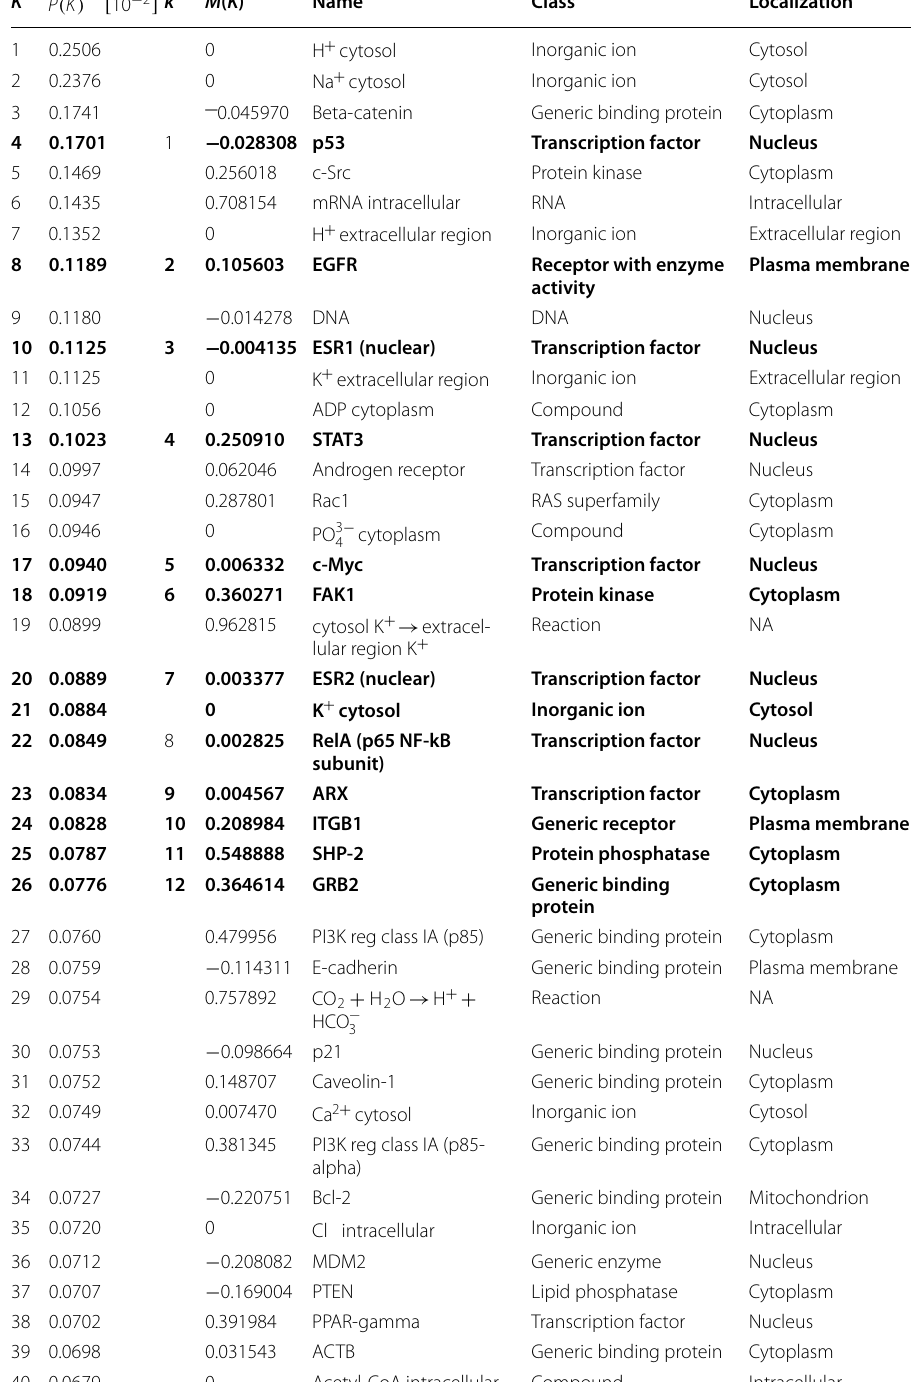
Table 1 Top 40 PageRank nodes of the simple MetaCore